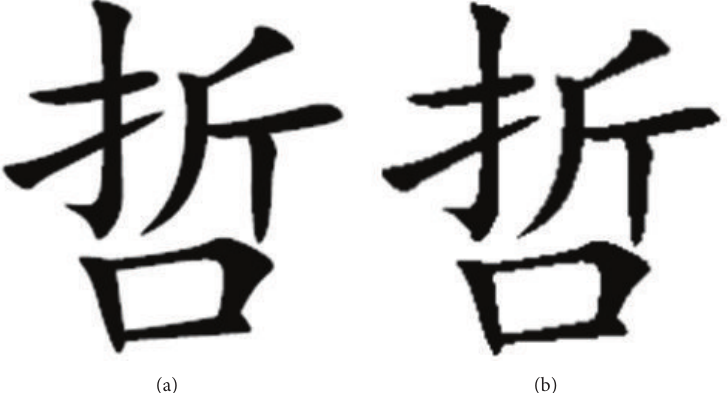
Figure 2: Comparison of the original image and the scaled one. (a) The original image; (b) the font image scaled by 102% using the bilinear interpolation